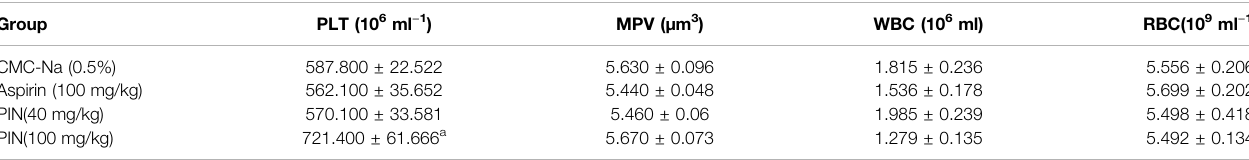
TABLE 1 | Effect of pimpinellin on coagulation index in mice.